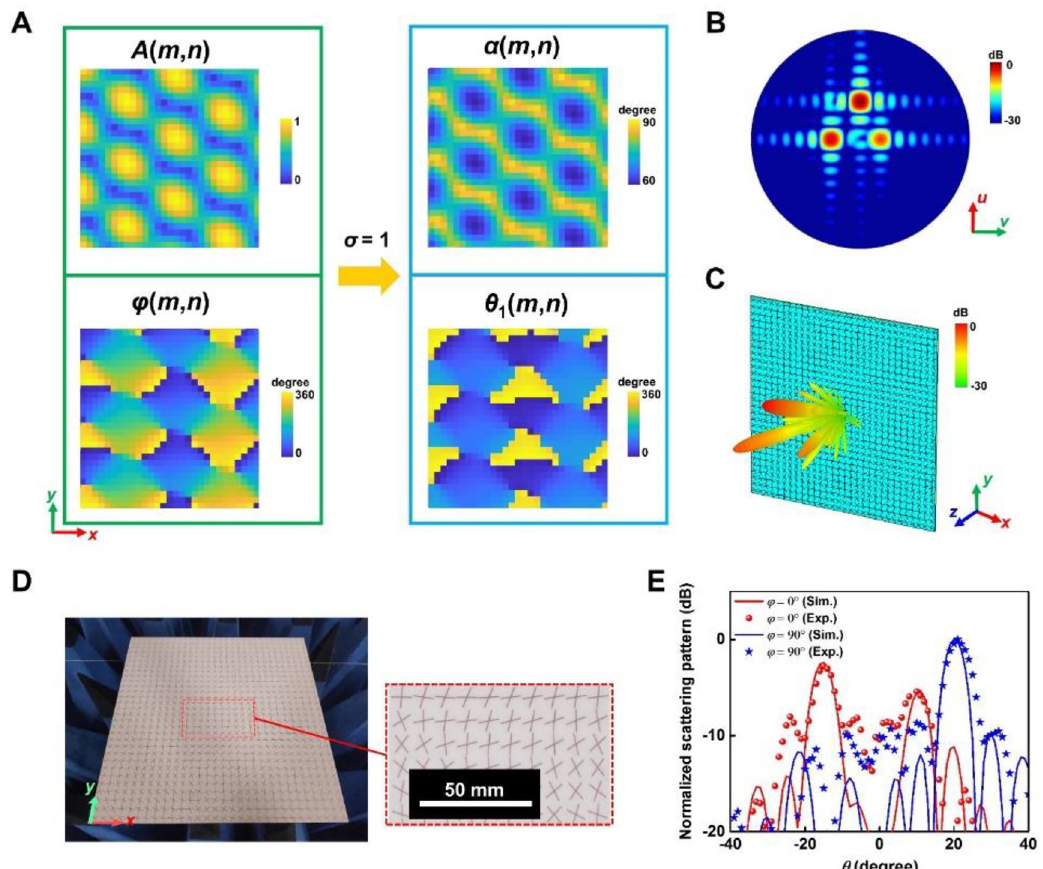
Figure 5: (A) The required amplitude, phase and geometric parameters α mn ( θ 1 mn ) distributions for the desired triple-beams metasurface. (B) The theoreticaland (C) corresponding simulated 3D normalized scattering pattern for the RCP incidence at 8.6 GHz. (D) The photograph of the fabricated sample. Inset shows the enlarged view. (E) The theoretical, simulated and measured 2D normalized scattering pattern for the RCP incidence in the xoz and yoz planes at 8.6